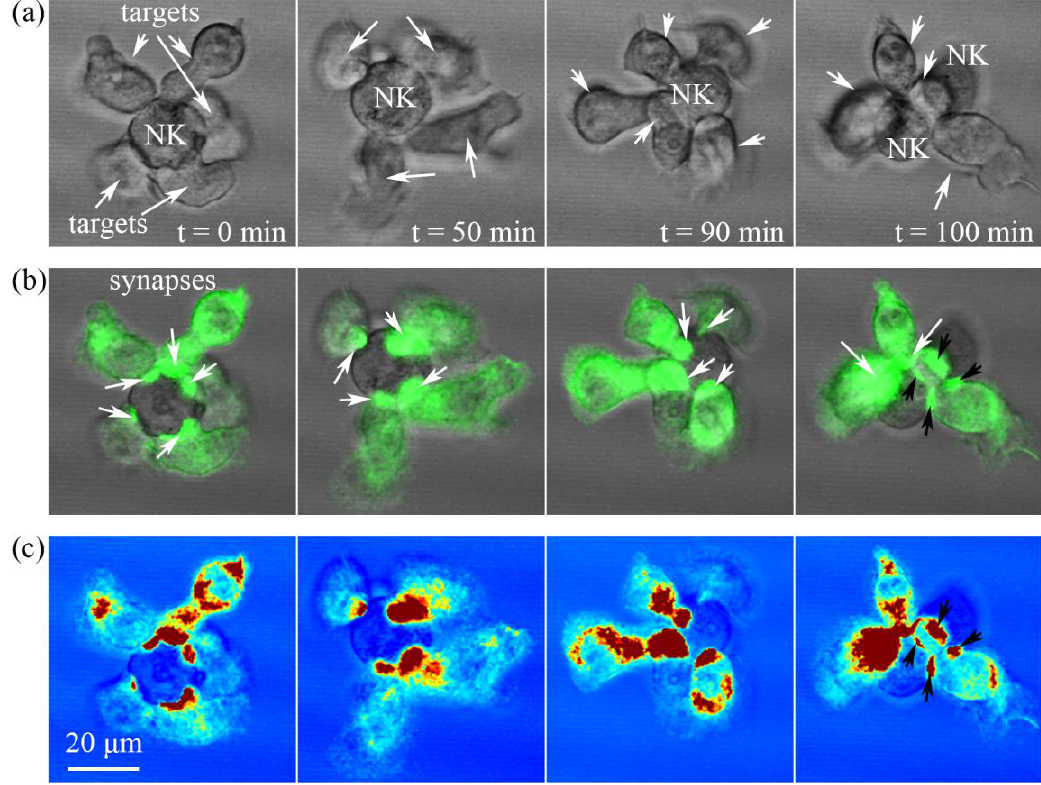
Figure 10. Time-lapse recordings of the inhibitory interaction between a single NK cell (YTS KIR2DL cell line) and five target cells (721.221/Cw6-GFP). ( a ) Bright field image of the interaction indicating the morphology of the cells. White arrows point out the target cells. At t = 100 min the NK cell has divided into two NK cells; ( b ) Merged images of bright field and green channel indicating the accumulation of GFP protein (white arrows) in the interface between each target cell and the NK cell (the immune synapse). At t = 100 min, two of the synapses (of two target cells) are shown to have divided (black arrows) at the site of the NK cell division (GFP gap); ( c ) False-color coding of the green fluorescence clustering at the immune synapse. Again the divided synapses are highlighted with black